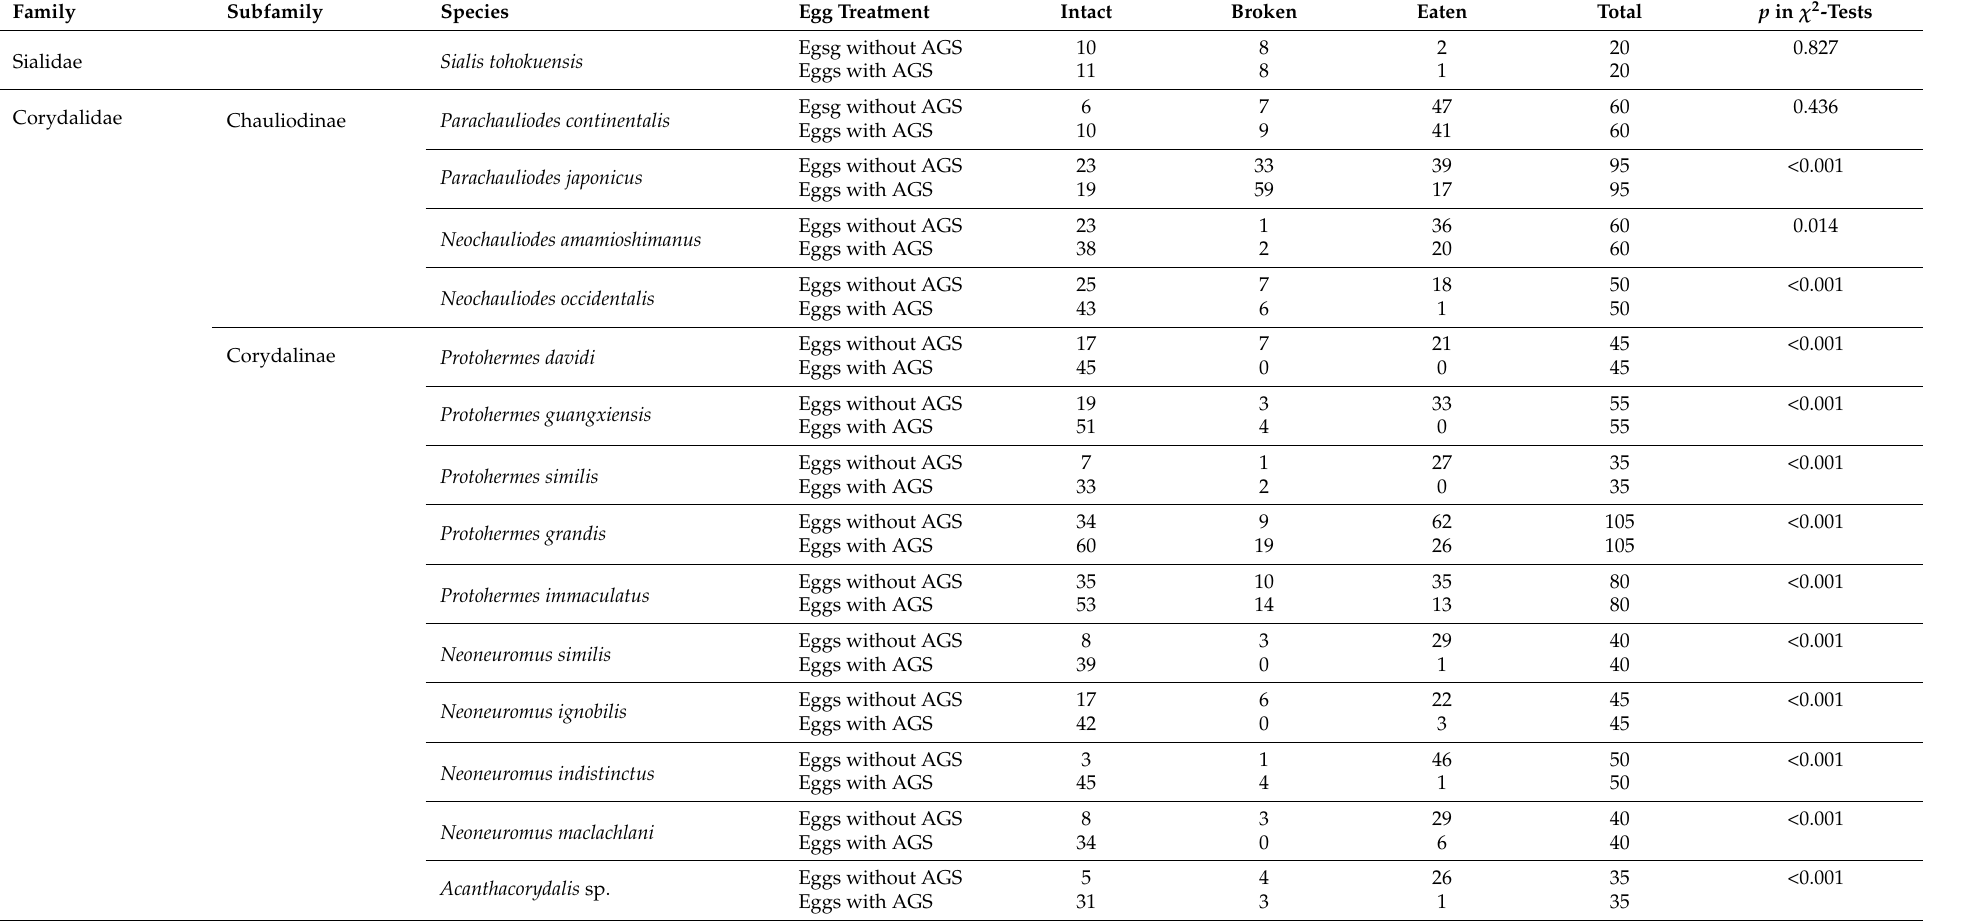
Table 2. Predation of eggs of 15 Megaloptera species coated and uncoated with female accessory gland substances (AGS) after 24 h exposure to ladybird beetles, Harmonia axyridis (see Figure 1c). p -values were determined by the chi-square